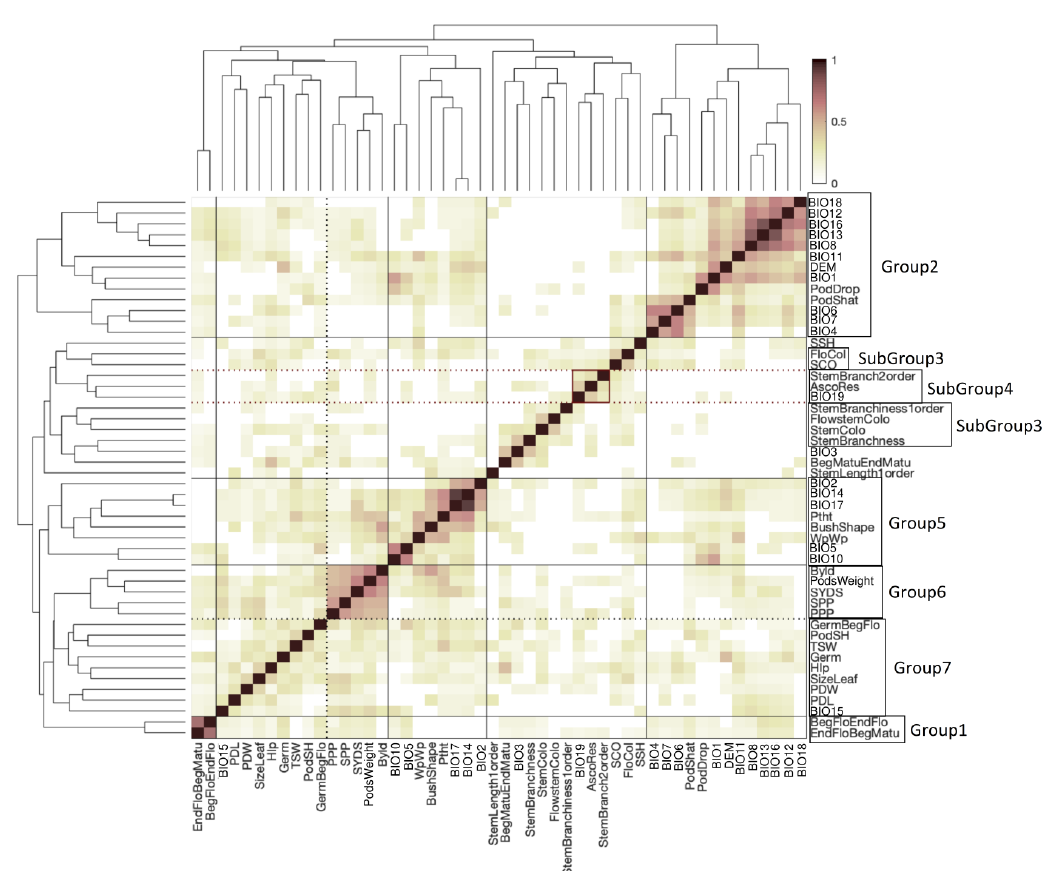
Figure 8. The degree of overlap in haploblocks enriched for SNPs associated with phenotypes and variables. Bi-clustering of similarity scores reveals several visually distinct groups of phenotypes. The haploblock similarity score is defined as a double sum of haploblocks simultaneously enriched for SNPs for both traits normalized to the amount of significantly enriched haploblocks for each trait. The degree of similarity is color coded.